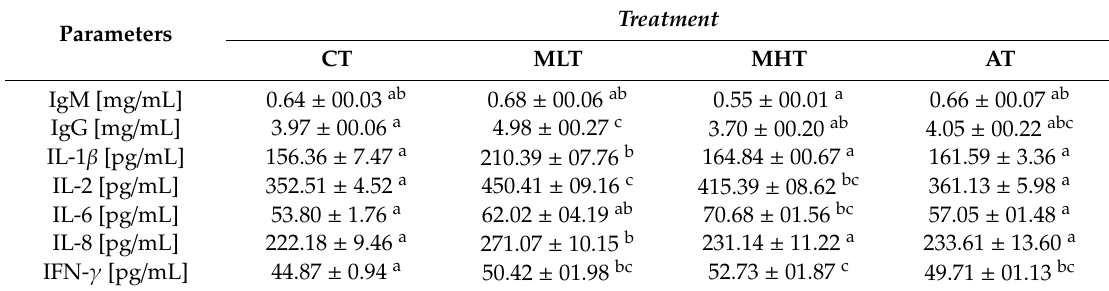
Table 3. E ff ects of MLPs on the concentrations of immunoglobins and cytokines in weaning pigs’